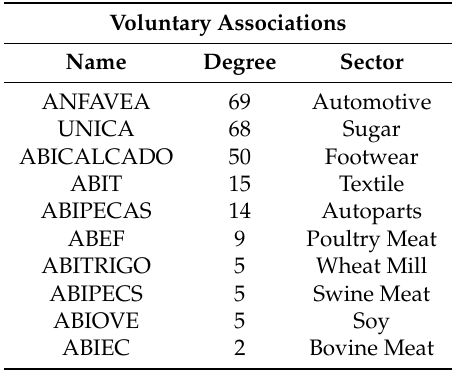
Table A1. Voluntary associations’ degree